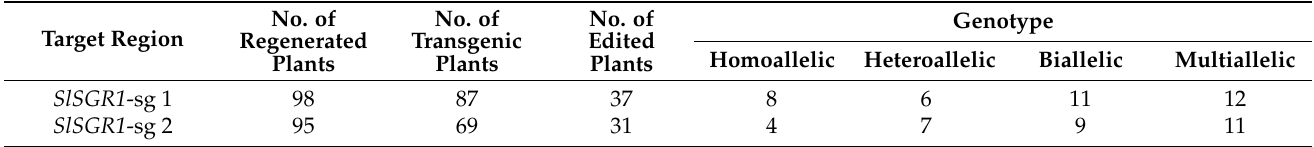
Table 1. Frequencies of transgenic plants and genotypes of the target gene region based on genome editing of Solanum lycopersicum stay-green 1 ( SlSGR1 ) gene using the clustered regularly interspaced palindromic repeat (CRISPR)/CRISPR-associated protein 9 (Cas9)